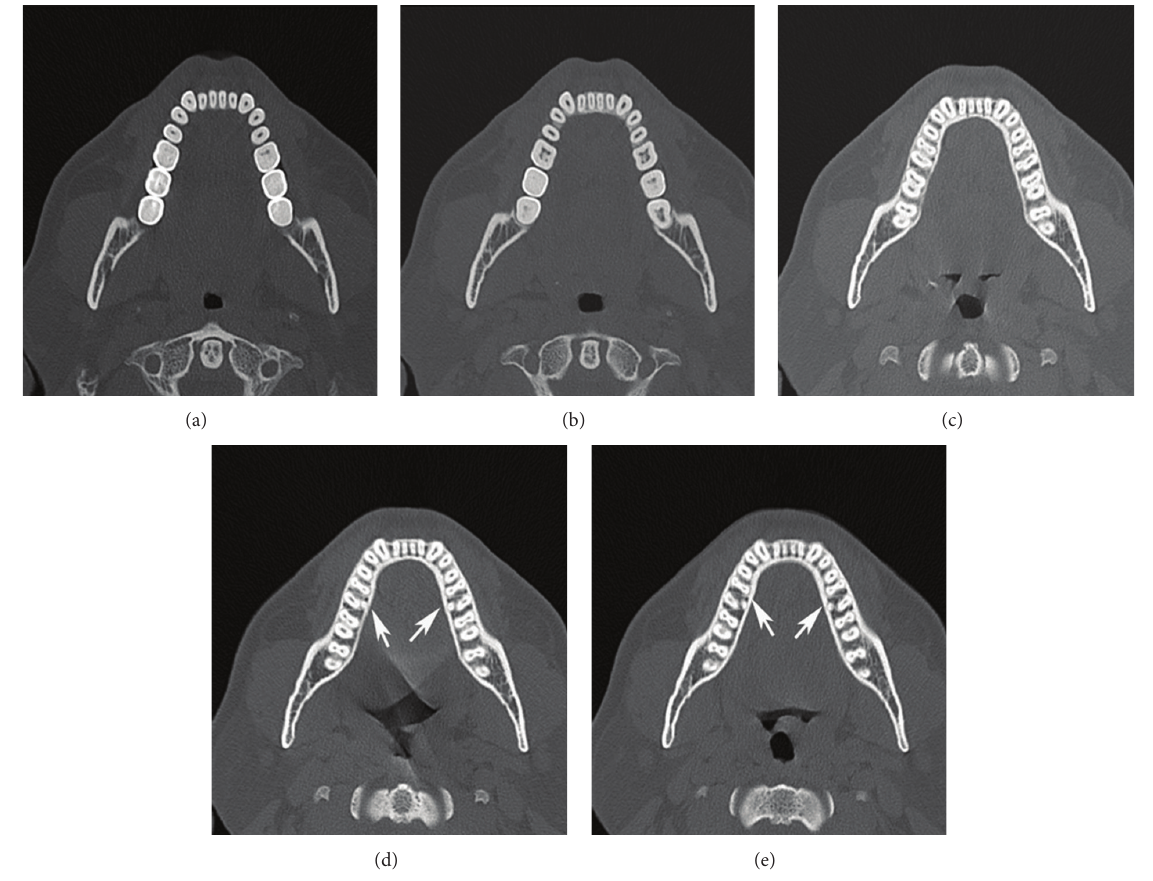
Figure 1: Axial CT scans of bilateral permanent three-rooted mandibular first molars. (a) Coronal section, (b) pulp-chamber section, (c) coronal-third root section, (d) mid-root section, and (e) apical-third root section. Arrows indicate bilateral extra DL roots.